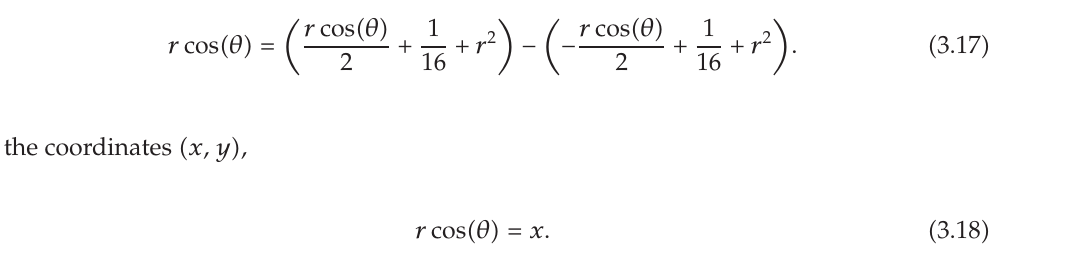
Figure 3 represents graphically Identity (cid:4) 3.17 (cid:5)